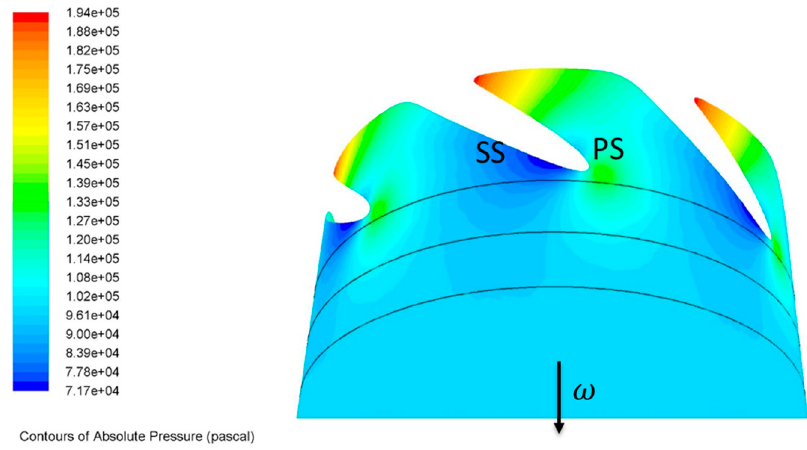
Figure 17. Contours of the static pressure (N/m 2 ) evidencing the pressure gradient across the blade trailing edge and at the mean radius.